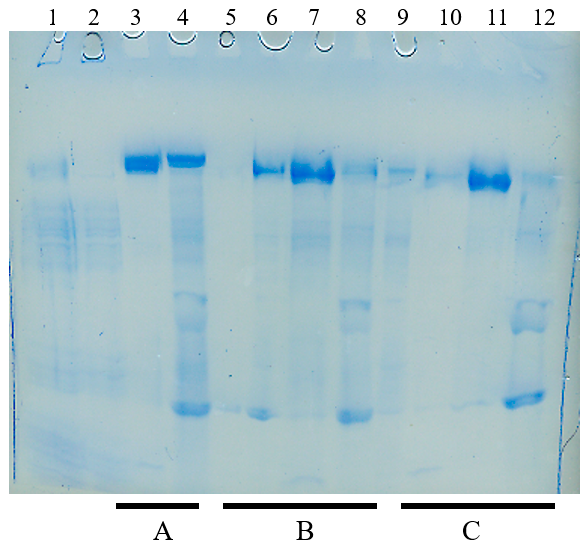
Figure 8. MEP chromatography of mAb-X. Three different protocols, A, B and C, were used as depicted in the inset to Figure 9. ( A ) Low pH elution (vendor’s protocol): no peak was observed with 100 mM acetate, 0.5 M NaCl. Lanes in SDS-PAGE: 1, Load; 2, FT; 3, 50 mM acetate (pH 5.0); 4, 0.1 M citrate (pH 3.0). ( B ) Arginine elution-1 (current protocol). Lanes in SDS-PAGE: 5, 25% 2-propanol/0.1 M NaCl (pH 7.0); 6, 35% ethylene glycol (pH 7.0); 7, 1 M arginine (pH 7.0); 8, 0.1 M citrate (pH 3.0). ( C ) Arginine elution-2 (previous protocol). Lanes in SDS-PAGE: 9, 1 M urea (pH 7.0); 10, 0.4 M arginine (pH 7.0), 11, 1 M arginine (pH 7.0); 12 0.1 M citrate (pH 3.0).